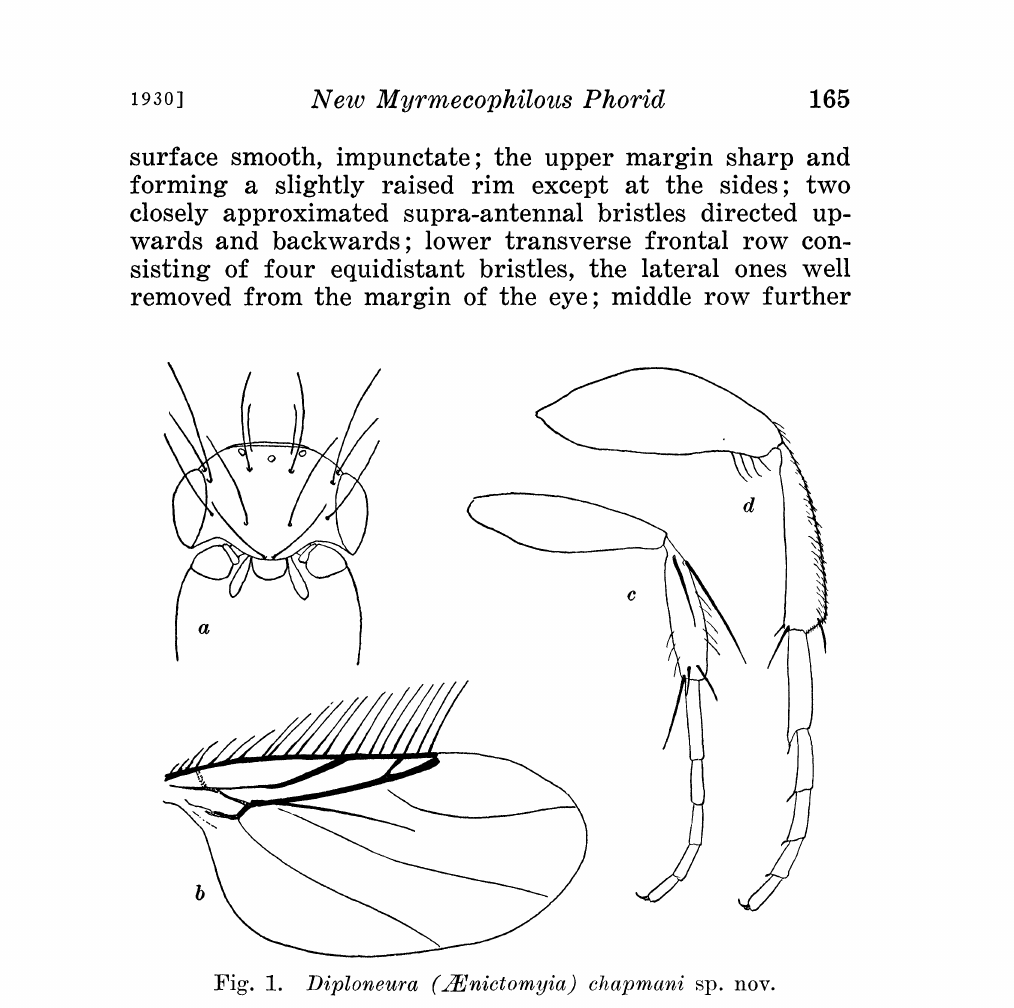
Fig. 1. Diploneura (.fEnictomyia) chapmani sp.